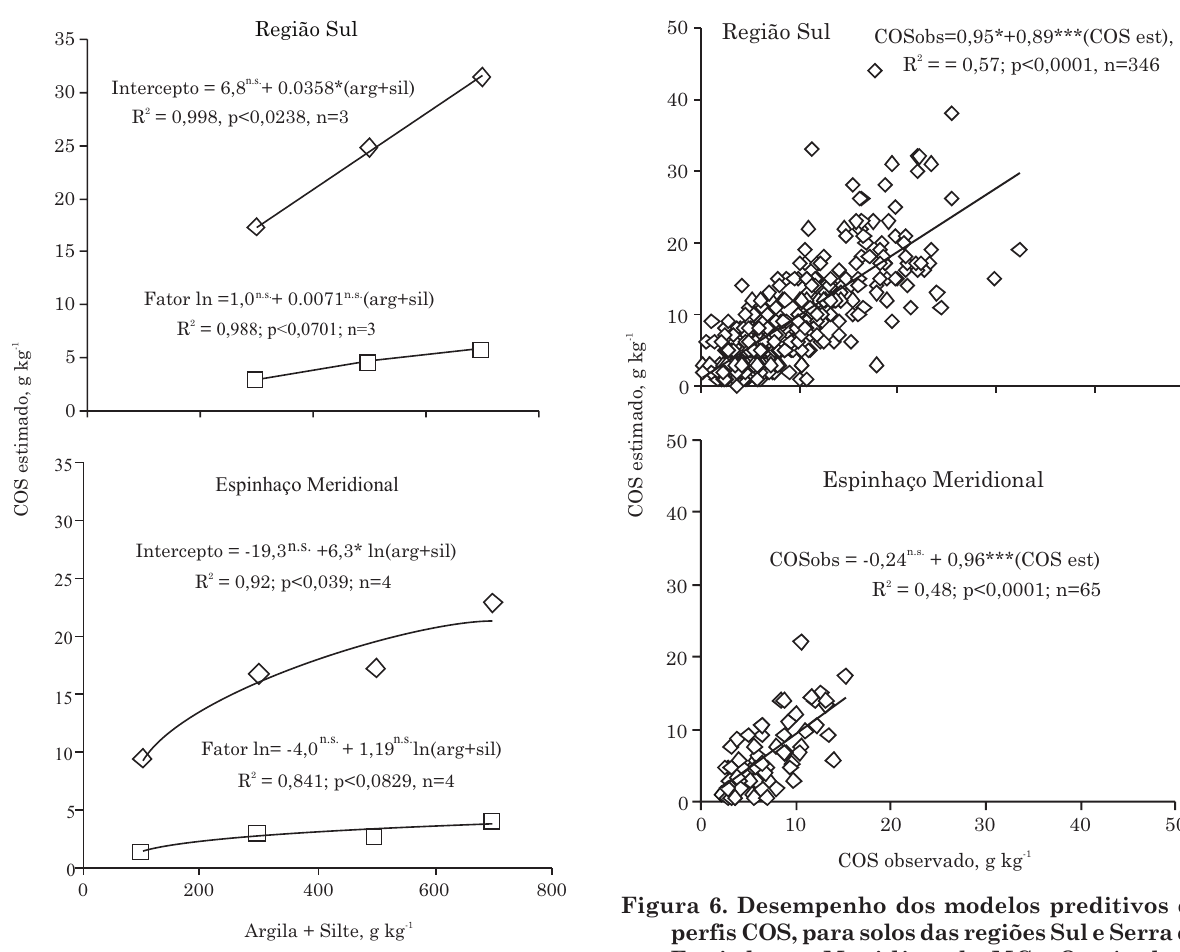
Figura 5. Modelagem dos parâmetros a e b das equações da figura 5 em função do teor de argila + silte, para solos das regiões Sul e Serra do Espinhaço Meridional, em MG. O nível de significância para os parâmetros intercepto e declive/fator logarítmico é representado por *, ** e ***, respectivamente, para p<0,05, p<0,01 e p<0,001.